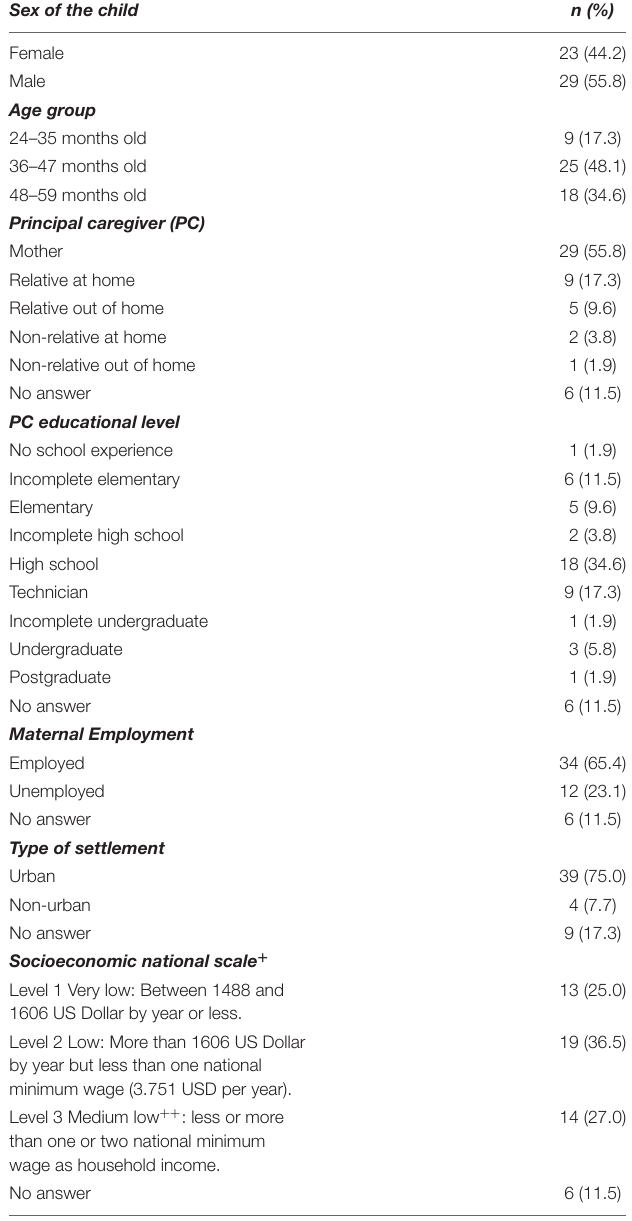
TABLE 1 | Characteristics of the sample for validation of CARE R (cid:13) ( n =